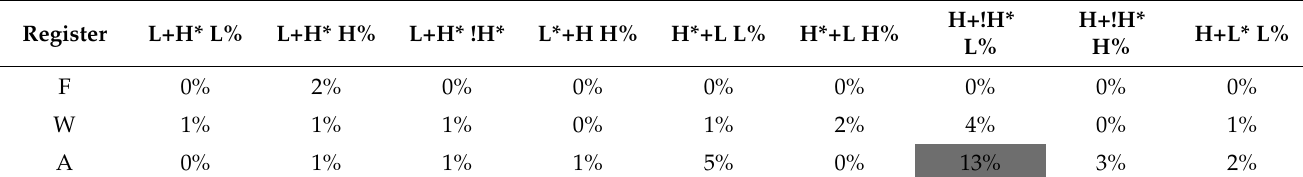
Table 6. Observed ‘complex’ nuclear contours, as a percentage of all in that register.